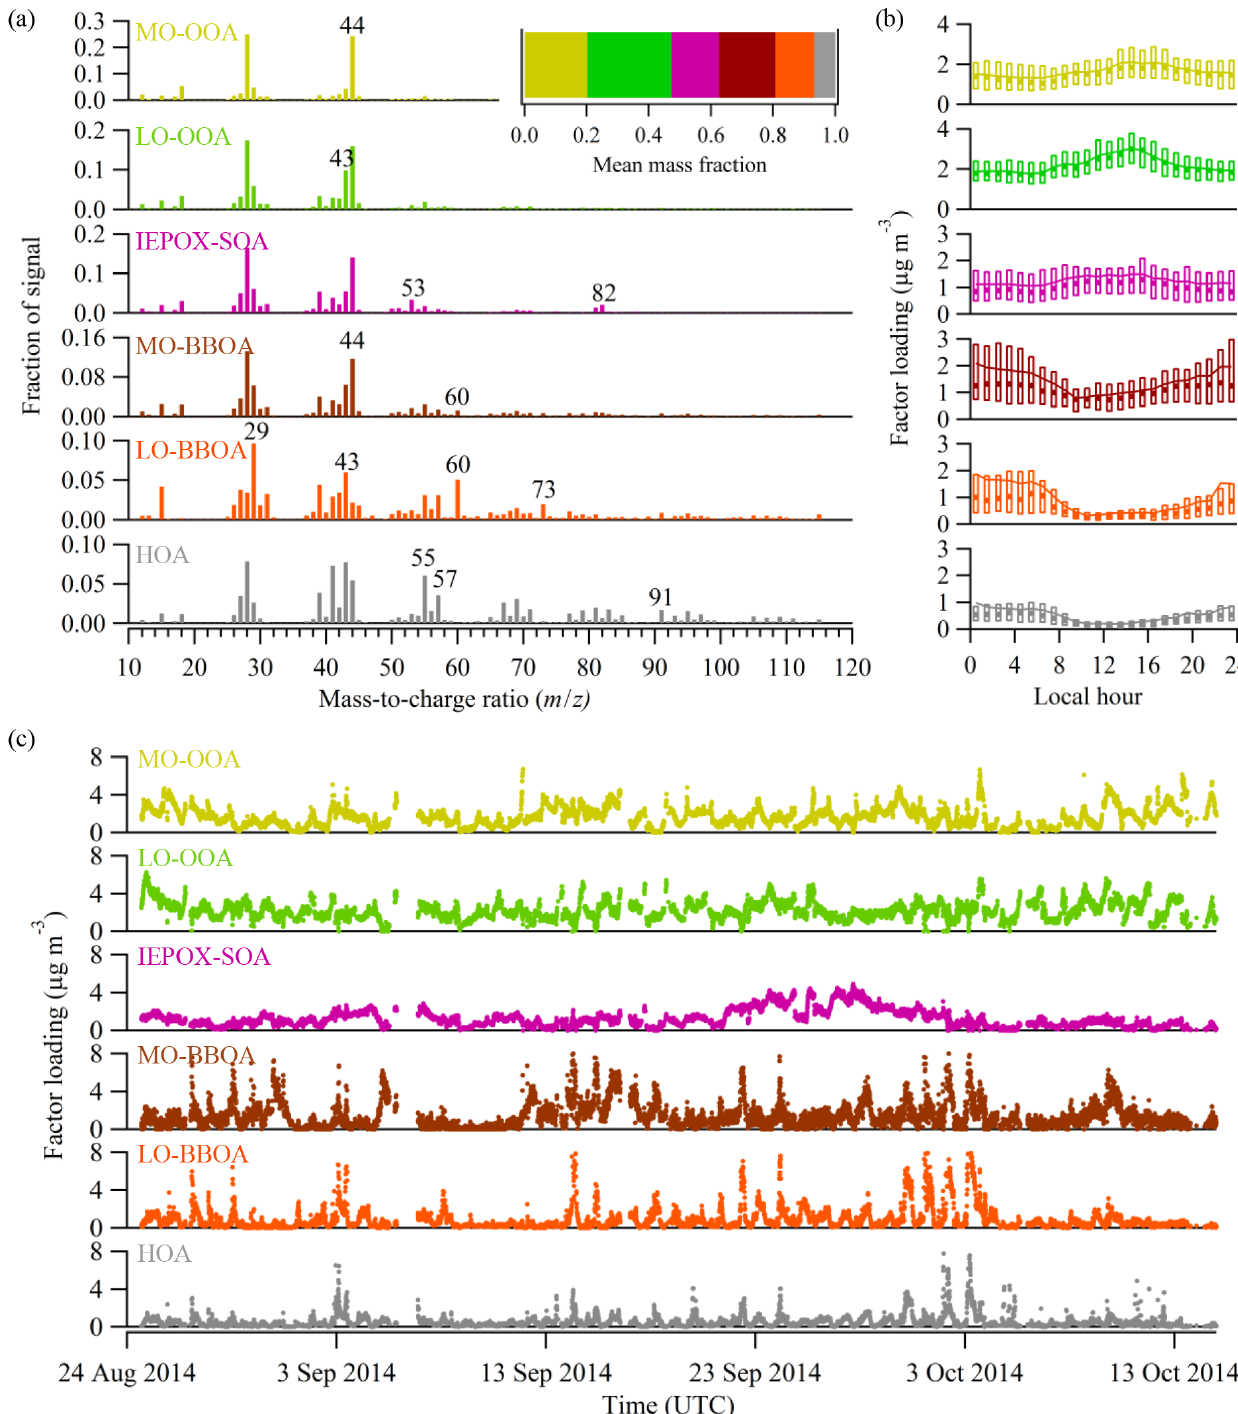
Figure 5. PMF analysis of the time series of AMS organic mass spectra collected at the T3 site. (a) Mass spectral profile of each factor represented at unit mass resolution. The inset shows the mean fractional loading of each factor. The factor profiles are shown in more detail, colored by ion families, in Fig. S5. (b) Diel trends for the loadings of each PMF factor. Local time is UTC minus 4h. Lines represent means, solid markers show medians, and boxes span interquartile ranges. (c) Time series of the factor